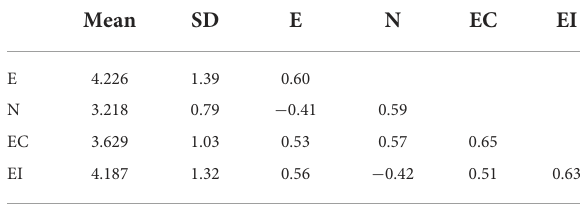
TABLE 2 Discriminant validity.